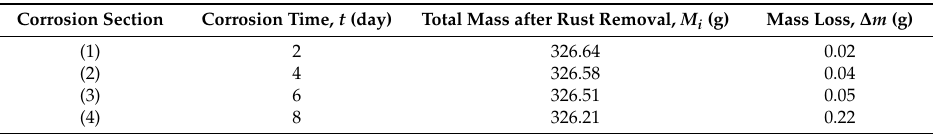
Table 3. The mass loss in four different corrosion sections.